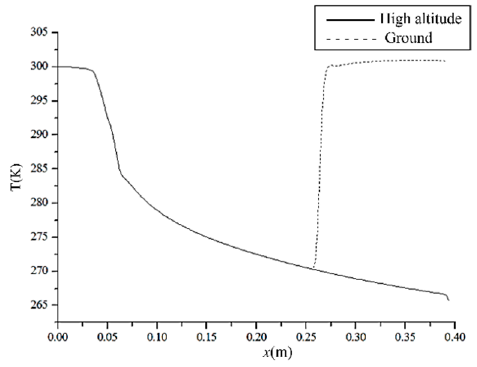
Figure 11. Temperature distribution, Pc = 4.34 MPa.